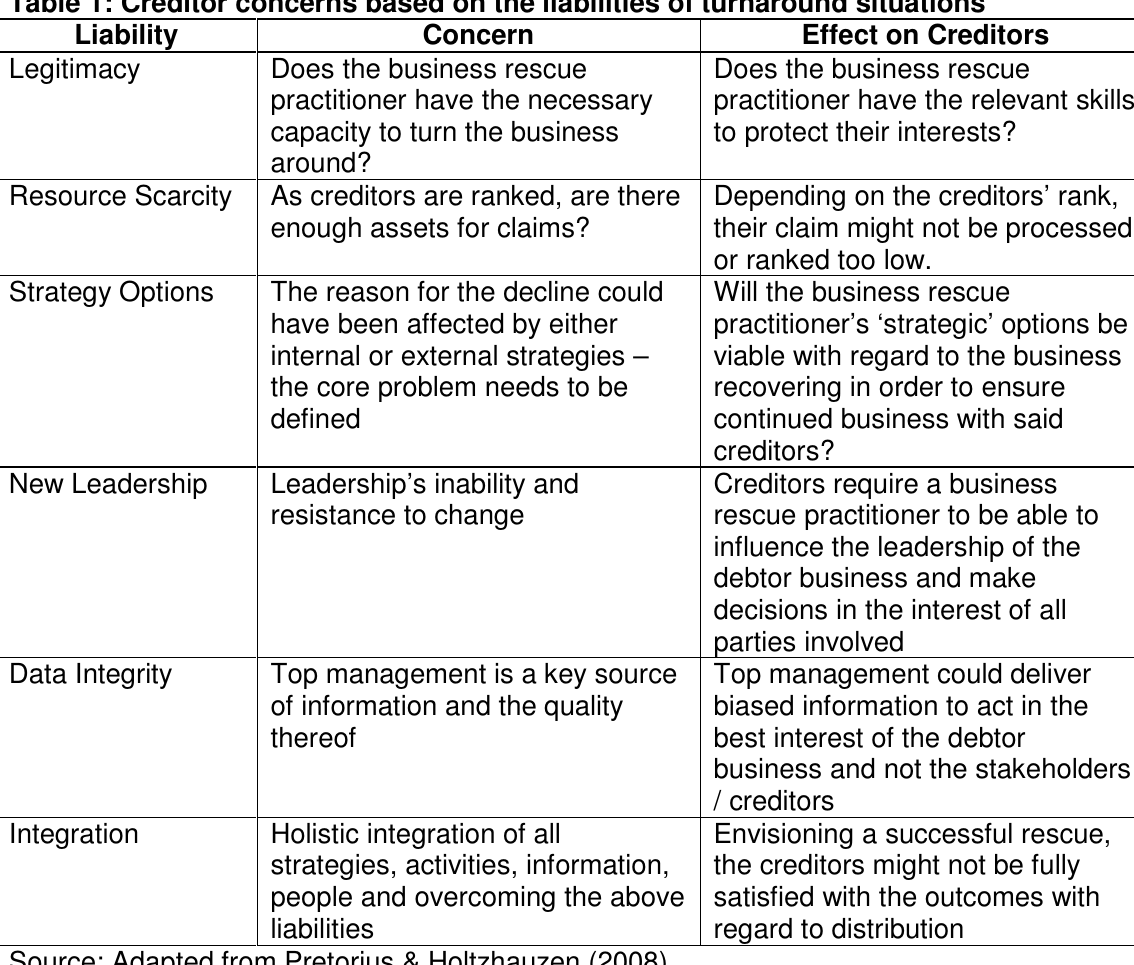
Table 1: Creditor concerns based on the liabilities of turnaround situations Liability Concern Effect on Creditors Legitimacy Does the business rescue Does the business rescue practitioner have the necessary practitioner have the relevant skills capacity to turn the business to protect their interests? around? Resource Scarcity As creditors are ranked, are there Depending on the creditors’ rank, enough assets for claims? their claim might not be processed or ranked too